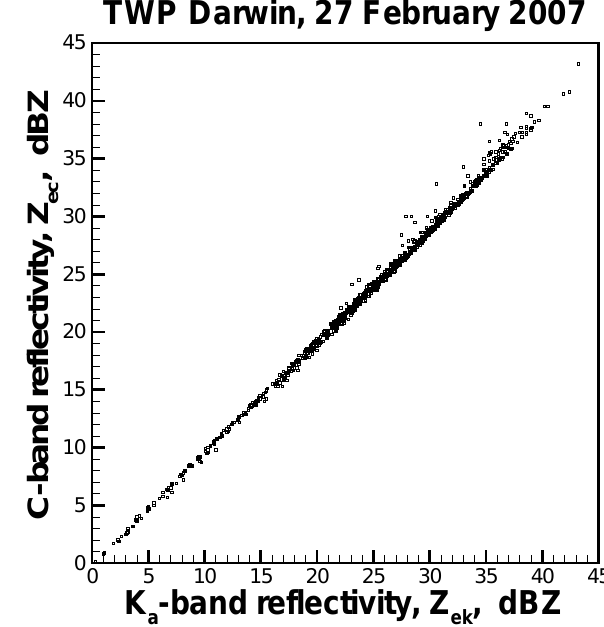
Fig. 6. Scatter plot of C-POL reflectivities versus MMCR reflectiv- ities as calculated from the JWD